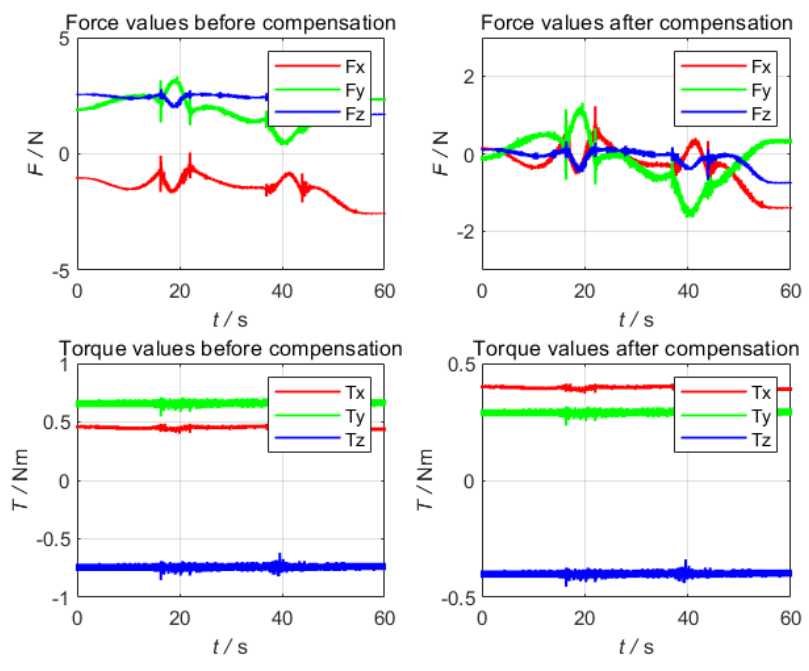
Figure 7. The result of the traditional compensation algorithm